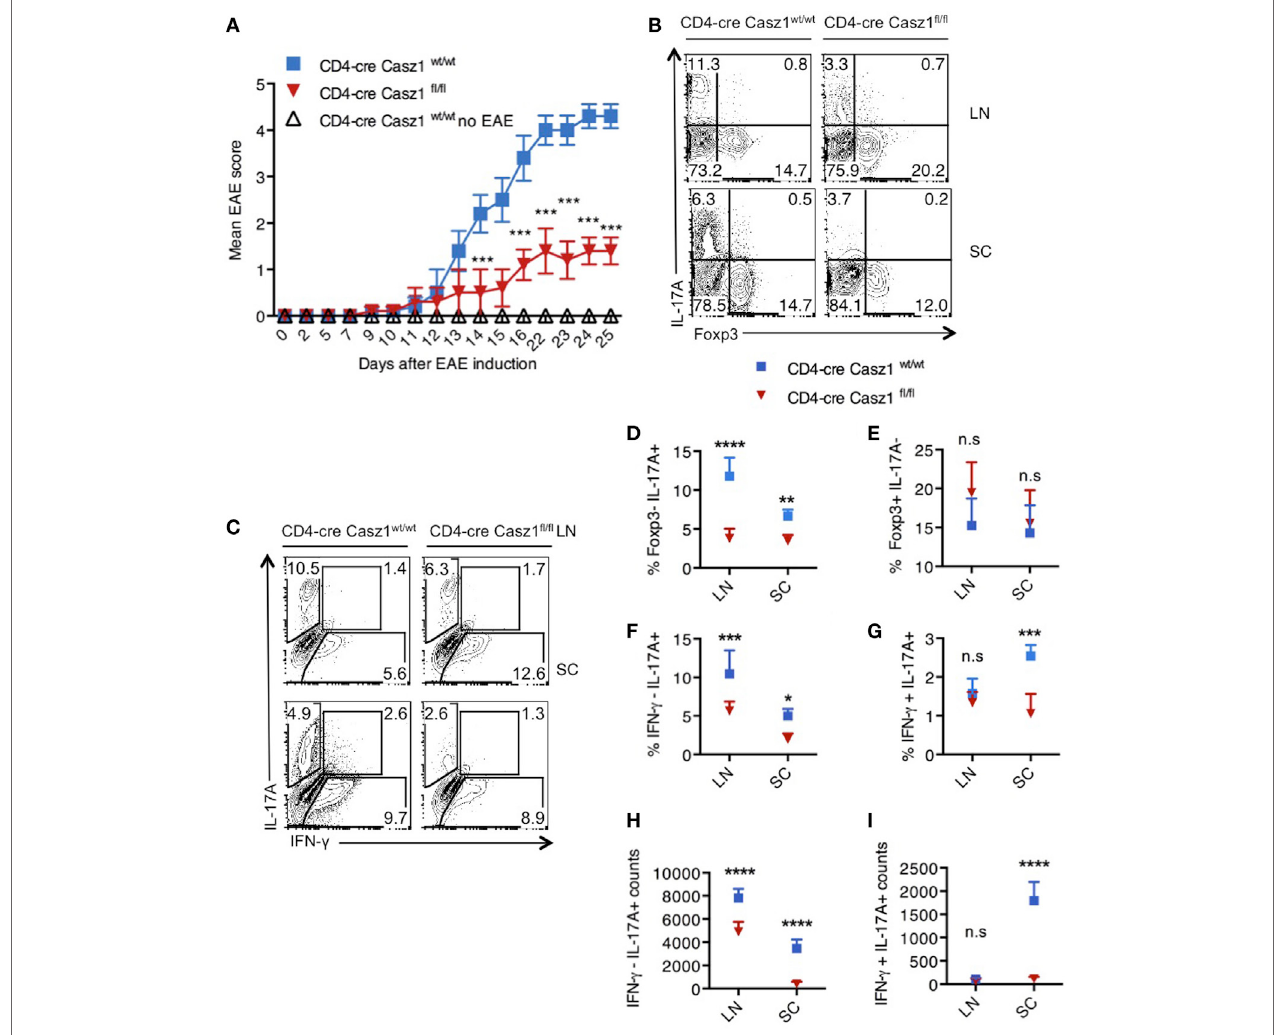
FigUre 4 | Loss of Casz1 ameliorates Th17 inflammation during experimental autoimmune encephalomyelitis (EAE) in vivo . (a) EAE was induced in 8- to 10-week-old Casz1 + / + WT (blue; n = 7) or Casz1 knockout (red; n = 6) mice using myelin oligodendrocyte glycoprotein (MOG) peptide. Some Casz1 + / + WT control mice were left untreated (white; n = 6; No EAE). EAE scores were recorded in masked fashion. Mean scores ± SEM are plotted. *** P = 0.002 was determined by two-way ANOVA t -test. (B) On day 10 after EAE induction, pooled axillary/inguinal lymph nodes (LN), or spinal cords (SC) were harvested for re-stimulation with MOG peptide and intracellular staining of Foxp3 (X axis) and IL-17A (Y axis) (B) , or IFN- γ (X axis) and IL-17A (Y axis) (c) (Gated on CD4 + cells). (D–i) The frequencies and cell counts of cytokine and Foxp3 expressing cells in LN or SC are plotted (gated on CD4 + cells). Mean ± SEM of each group is shown. Two-way ANOVA with Bonferroni’s post hoc analyses were performed to determine significance. These data represent three independent experiments. Gates were drawn using unstain or isotype